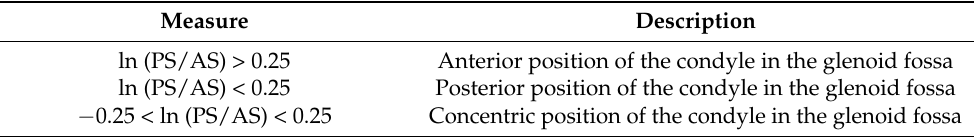
Table 1. Condylar position classification according to Pullinger and Hollender. Measure Description ln (PS/AS) > 0.25 Anterior position of the condyle in the glenoid fossa ln (PS/AS) < 0.25 Posterior position of the condyle in the glenoid fossa − 0.25 < ln (PS/AS) < 0.25 Concentric position of the condyle in the glenoid fossa AS, anterior space; P, posterior